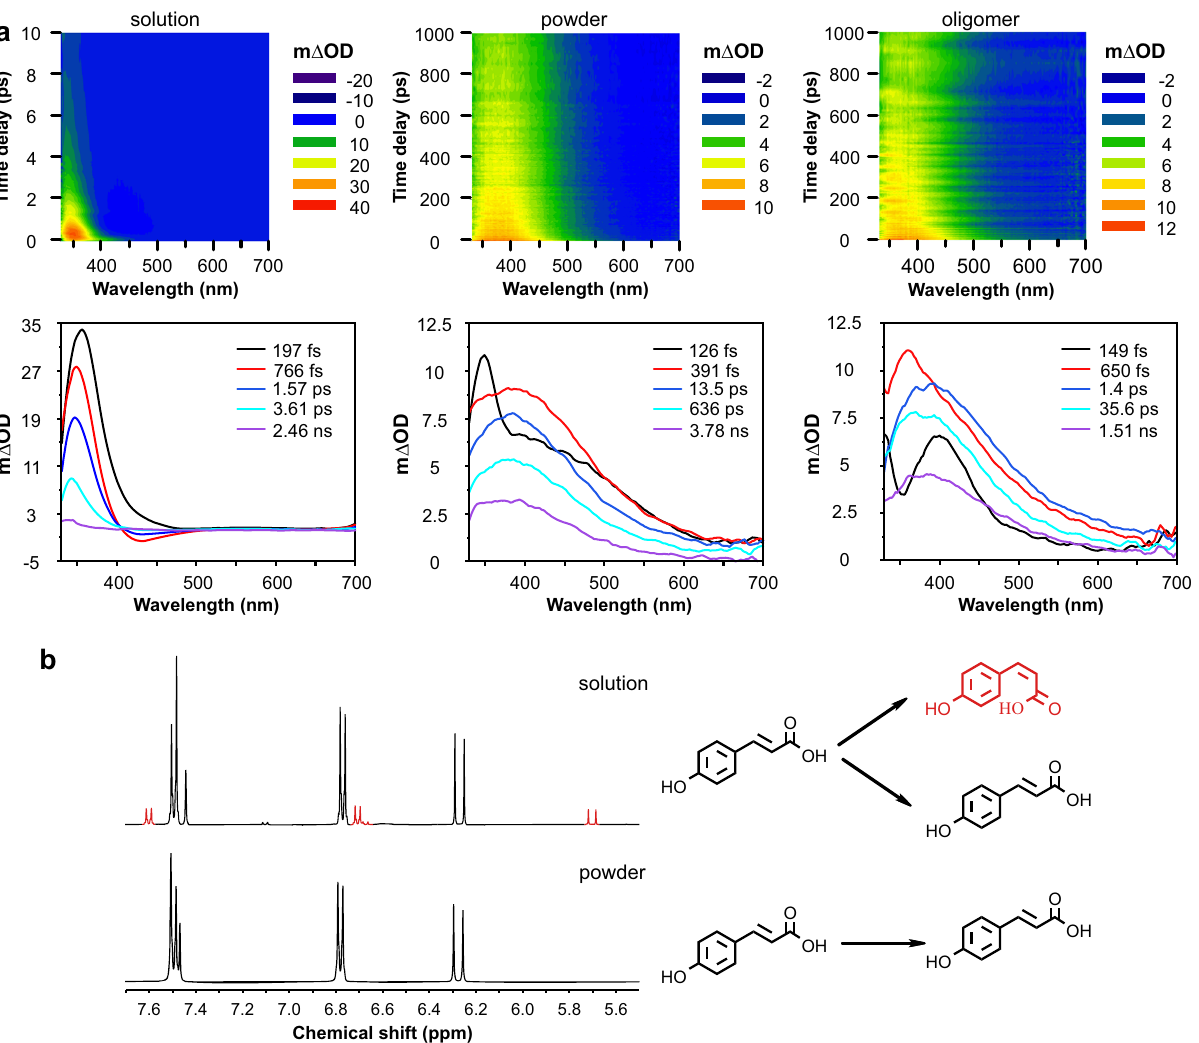
Fig. 2 Transient absorption spectra (TAS) of p- coumaric acid in different environments. a TAS of a methanol solution of p -coumaric acid (10 − 3 M), powder p- coumaric acid and a polyalkylcoumarate oligomer. Top, heat maps displaying changes in optical density (m Δ OD) with time and wavelength after a pump pulse of 300 nm. Bottom, TAS graphs display the evolution of differences in absorbance with wavelength at given delay times. b NMR spectra after 5 h of continuous irradiation at 300 nm of p -coumaric acid solution and solid samples. Red peaks in the solution sample are characteristic of the cis -isomer whereas those in black are of trans -isomer. To the right, a schematic representation of the processes occurring during sample irradiation. In black trans p - coumaric acid, in red cis p -coumaric